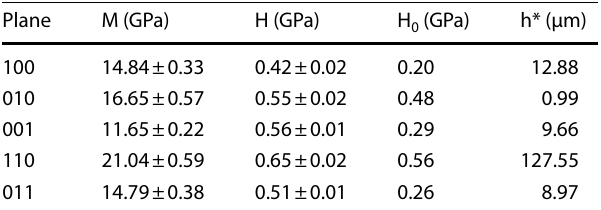
Table 2 Properties obtained for each tested plane of β-HMX by indentation